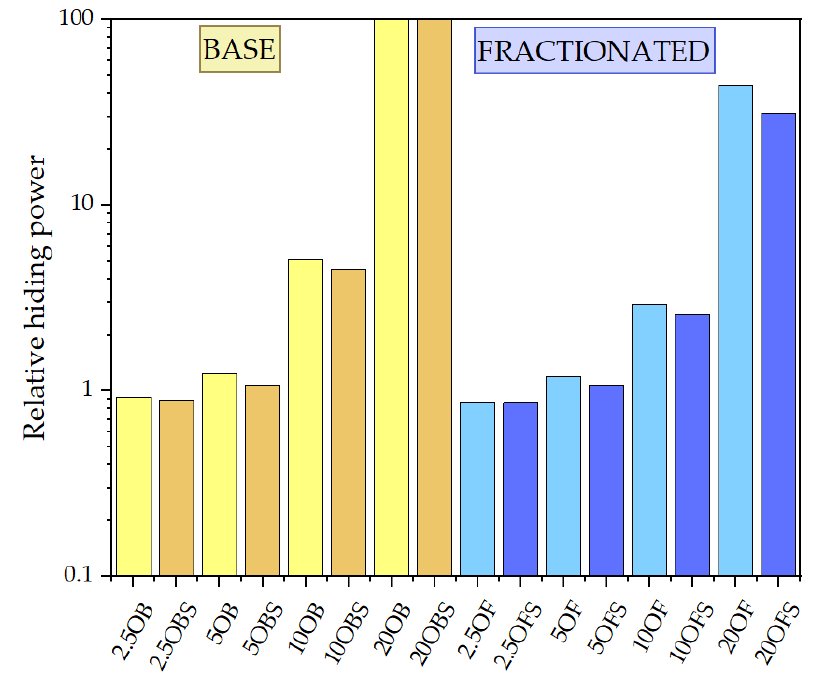
Figure 23. Relative hiding power.